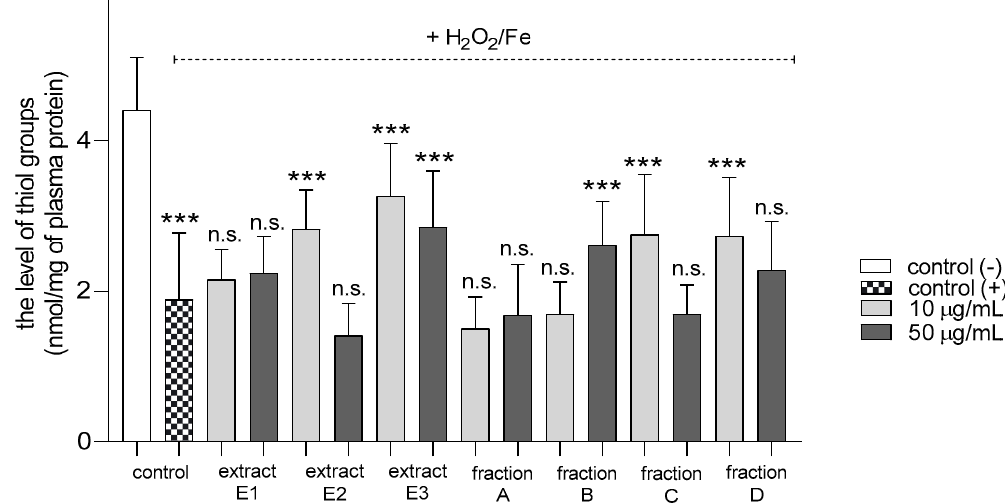
Figure 3. Effects of extracts (E1–E3) and flavonoid fractions (A–D) of dandelion fruits (concentrations 10 and 50 µg/mL) on the level of thiol groups in plasma treated with H 2 O 2 /Fe. The data are presented as means ± SD ( n = 8). Control negative refers to plasma not treated with H 2 O 2 /Fe, and control positive to plasma treated with H 2 O 2 /Fe. Kruskal-Wallis test: n.s. p > 0.05, *** p < 0.001, compared with positive control. All tested dandelion fruit preparations inhibited protein carbonylation in plasma treated with H 2 O 2 /Fe at the highest tested concentration (50 µg/mL) (Figure 4). In addition, two extracts (E1 and E3) and two fractions (C and D) were also active at the lower tested concentration (10 µg/mL).